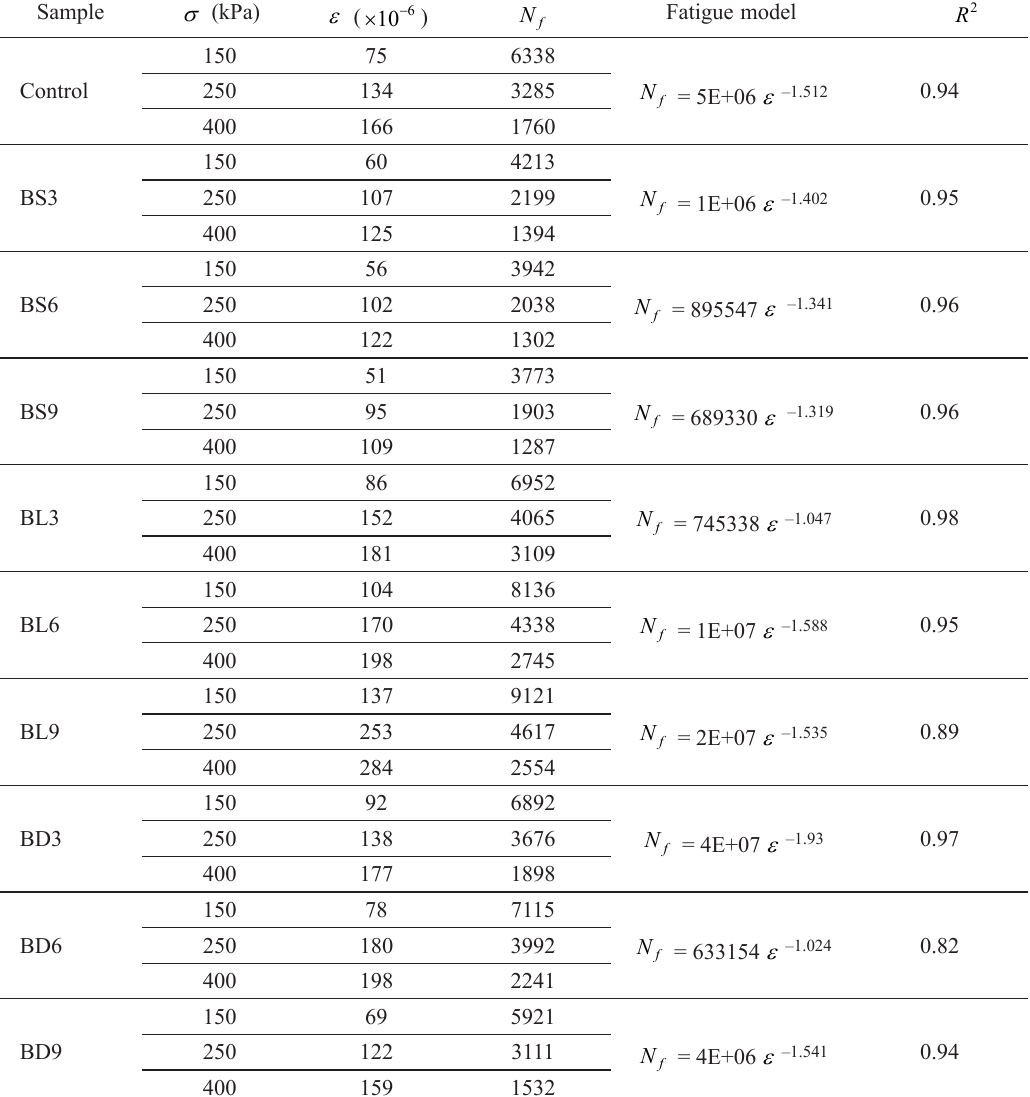
Table 5. ITFT fatigue testing results of mixes containing various amounts of additives